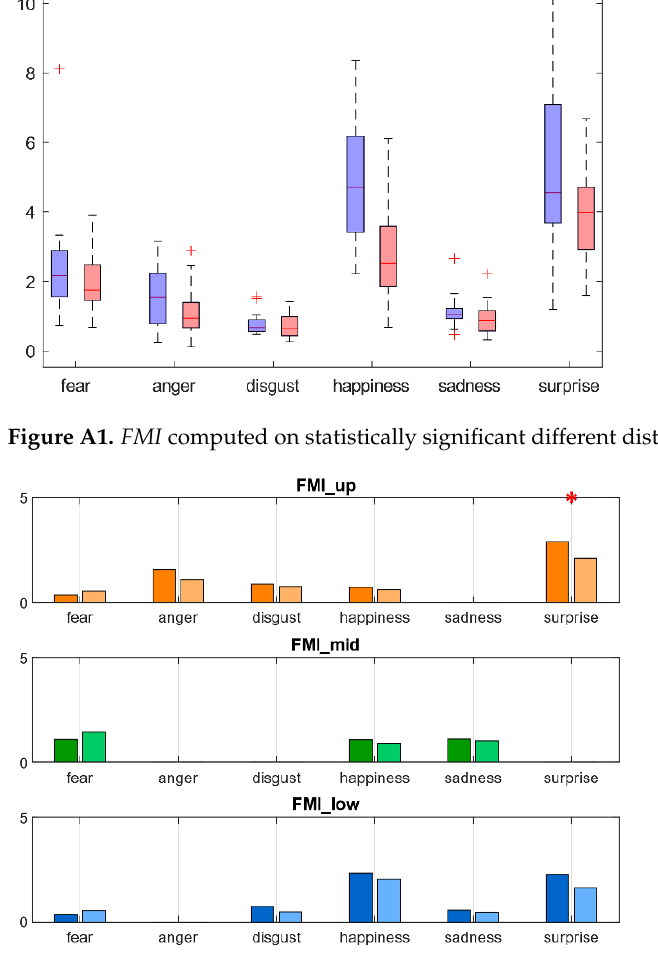
Figure A2. FMI computed on statistically significant different distances per face region. Red * highlights statistically significant differences at the 0.05 confidence level.